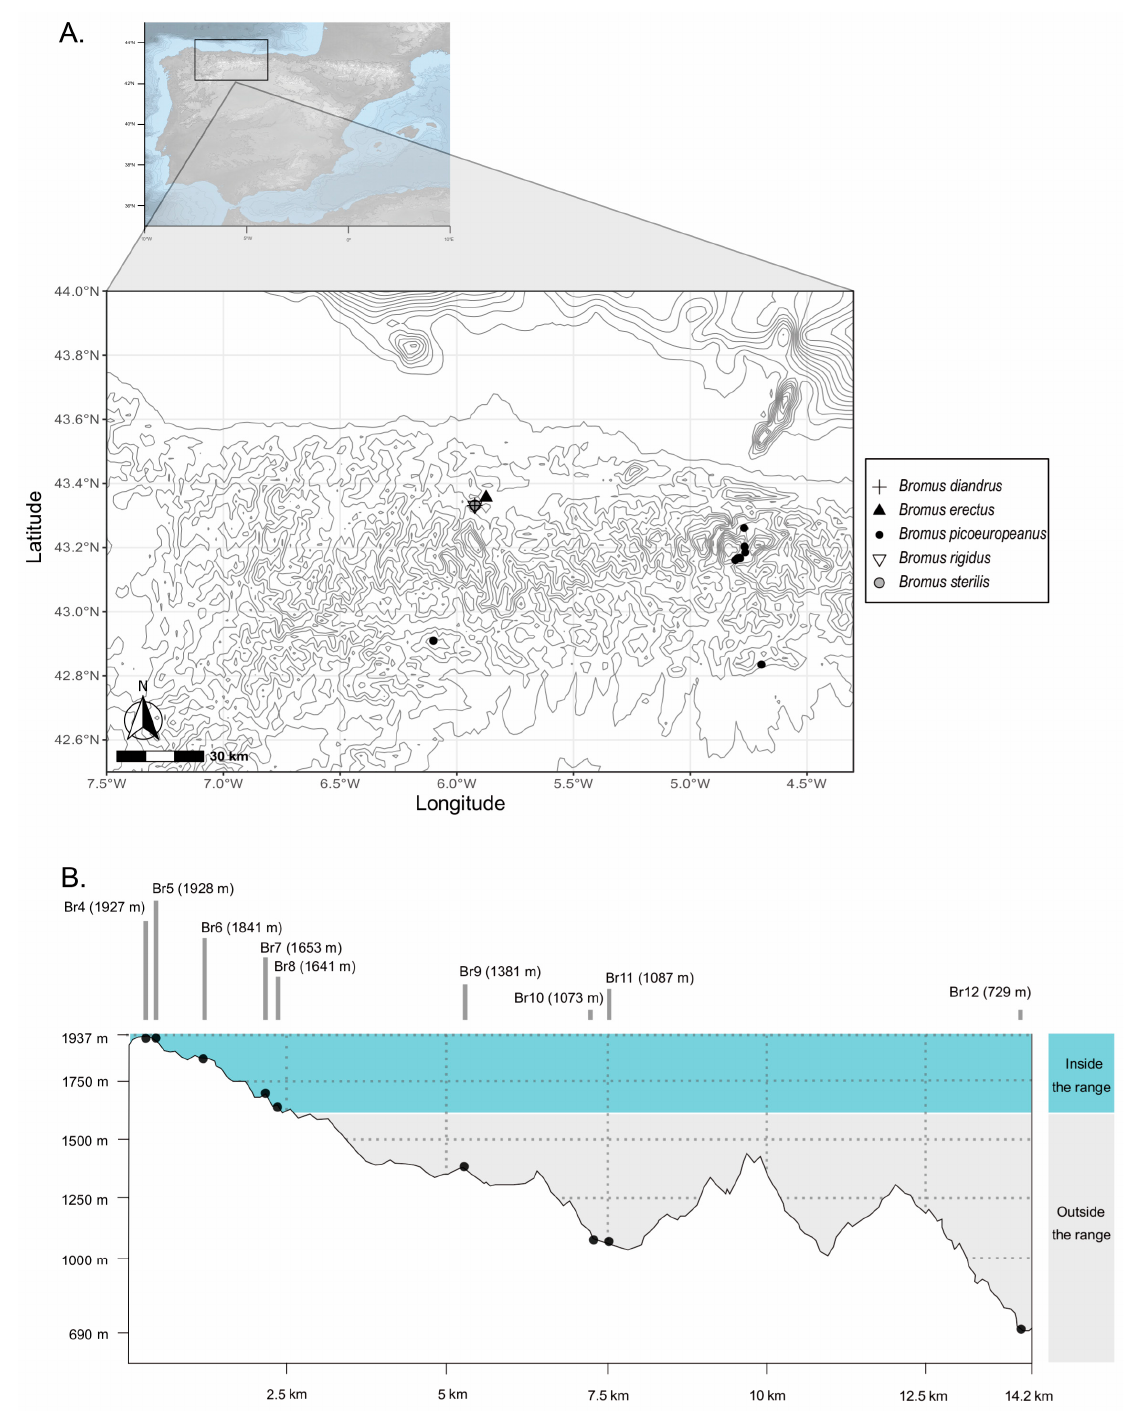
Figure 7. ( A ) Sampling area of the Bromus samples of this study, comprising collations in the Principality of Asturias, Cantabria, Le ó n and Palencia. The black dots (individuals Br2-12) and the black triangle (individual Br1) represent the sampled individuals of the B. erectus complex (i.e., B. erectus s. l.), while the cross, the white triangle and the grey dots represent the B. diandrus , B. sterilis and B. rigidus individuals, respectively. ( B ) Vertical profile of the clinal sampling of Bromus picoeuropeanus samples (Br2-12) in Picos de Europa mountainous area. The altitudes (measured in meters above sea level (m. a. s. l.) inside the B. picoeuropeanus range as defined by Acedo and Llamas [29] have been highlighted in blue, while altitudes outside this range have been highlighted in gray.